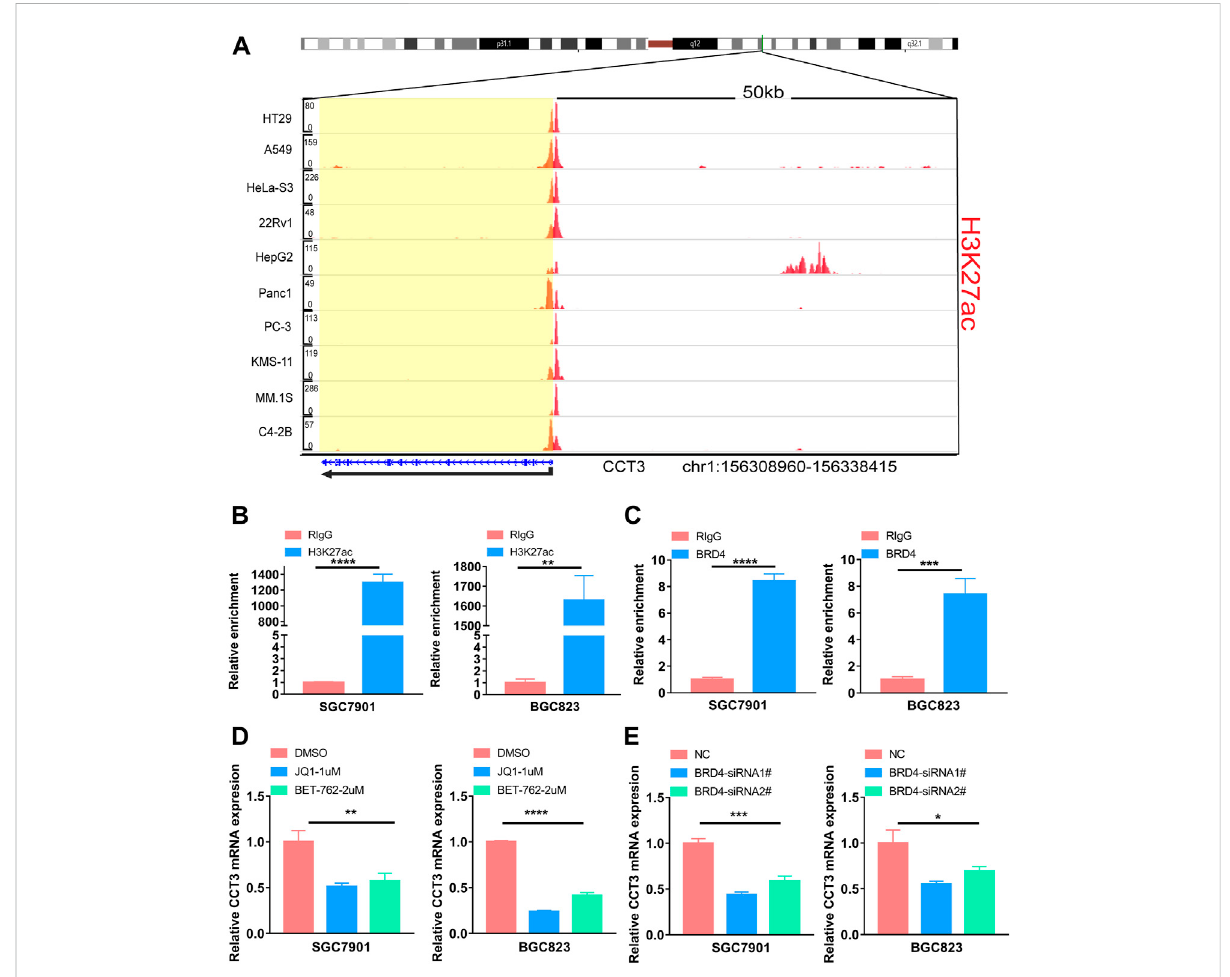
The effect of enhancers on CCT3 expression. (A) The H3K27ac signal of the CCT3 gene loci in different tumor cell lines was showed by WashU Epigenome Browser. (B – C) The relative enrichment levels of H3K27ac or BRD4 to CCT3 gene loci by ChIP-qPCR in gastric cancer cells. (D – E) The relative CCT3 expression after the treatment with enhancer inhibitors (JQ1 and I-BET-762) or BRD4